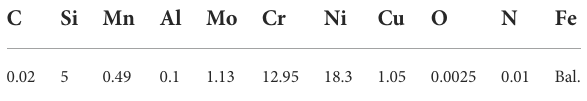
TABLE 1 Chemical composition of molten metal used in the study (wt%).